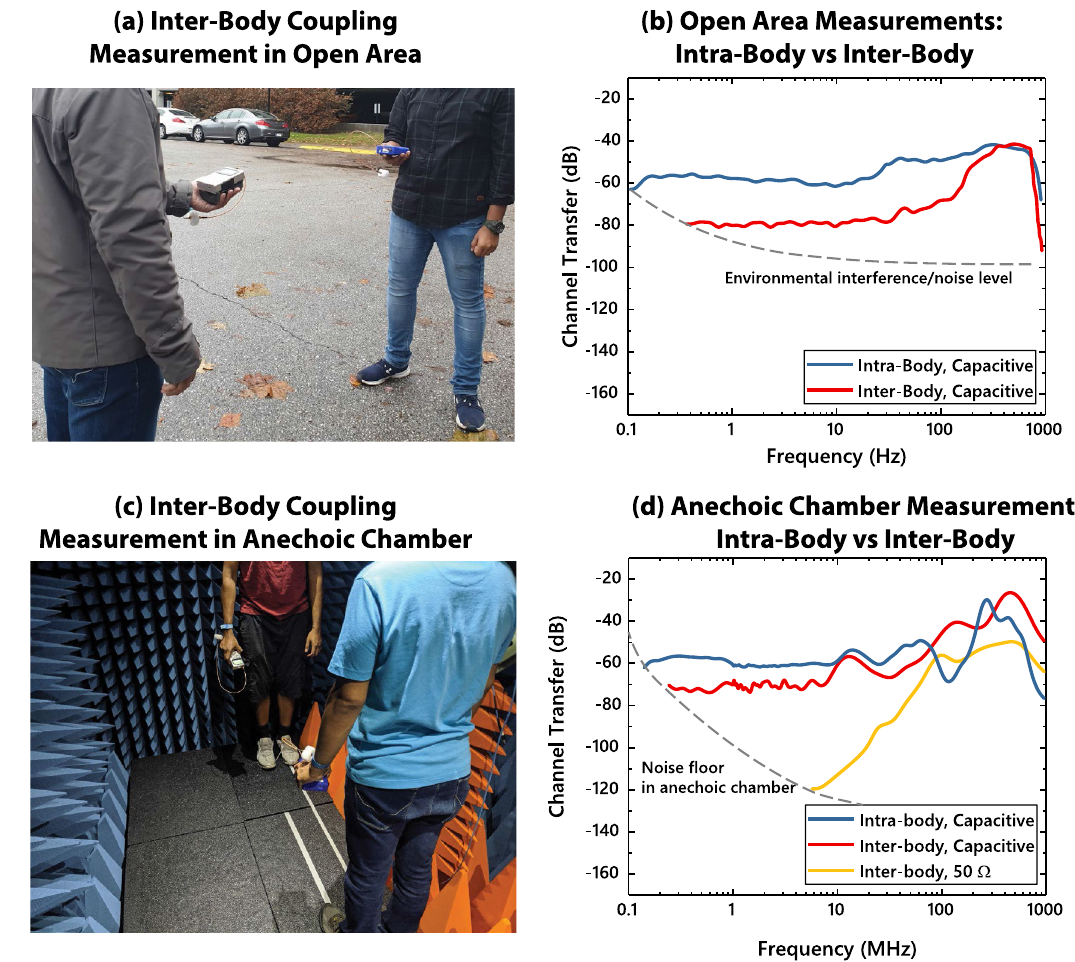
Figure 6. ( a ) Measurement setup in open-area. The subjects are kept at a distance of 1m for frequency sweep measurements. ( b ) Experiment results from open-area measurements. Multiple transmitting devices are used to cover the whole frequency range, as shown later in Fig. 9a. ( c ) Measurement setup inside anechoic chamber. ( d ) Results from measurements inside the anechoic connected devices, as wall connected devices share a common ground, and would hence reduce the channel loss and produce an inaccurate result. Now to cover the entire frequency range of our experiments, we split the range into multiple handheld RF generators—details of which can be found in the Methods section. Note that the ground sizes of the different transmitting devices are slightly different, and that in turn makes the transmitter side return path capacitance, C G , Tx slightly different between the devices. As a result, there are slight discontinui- ties in the plot of the measurement data, in Fig. 6b and 6d. However, we made sure to minimize these disconti- nuities through a rigorous calibration protocol, described later in the methods section. While performing the experiments inside the anechoic chamber (Fig. 6c) provides a controlled low-noise environment for gathering accurate frequency response, the chamber is enclosed in a grounded metal cage and that affects the low frequency EQS region of the results. First, the grounded metal cage increases the overall return path capacitance, and that reduces channel loss. Second, as the EQS region now shows lower loss, the crossover point between the EQS and EM regions moves to a higher frequency. The chamber used for our experiments